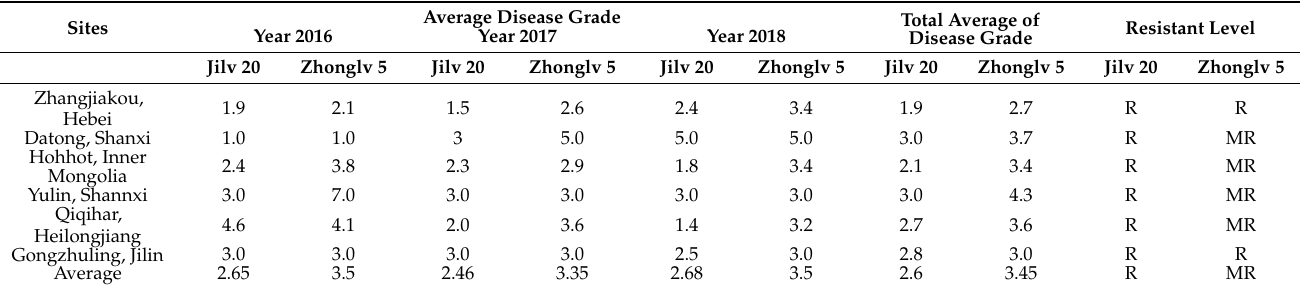
Table 3. Evaluation of Jilv 20 halo-blight